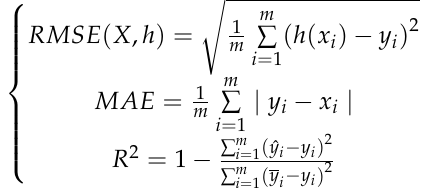
Table 7. Performance of the GWO-SVR screening model under two kernel functions.